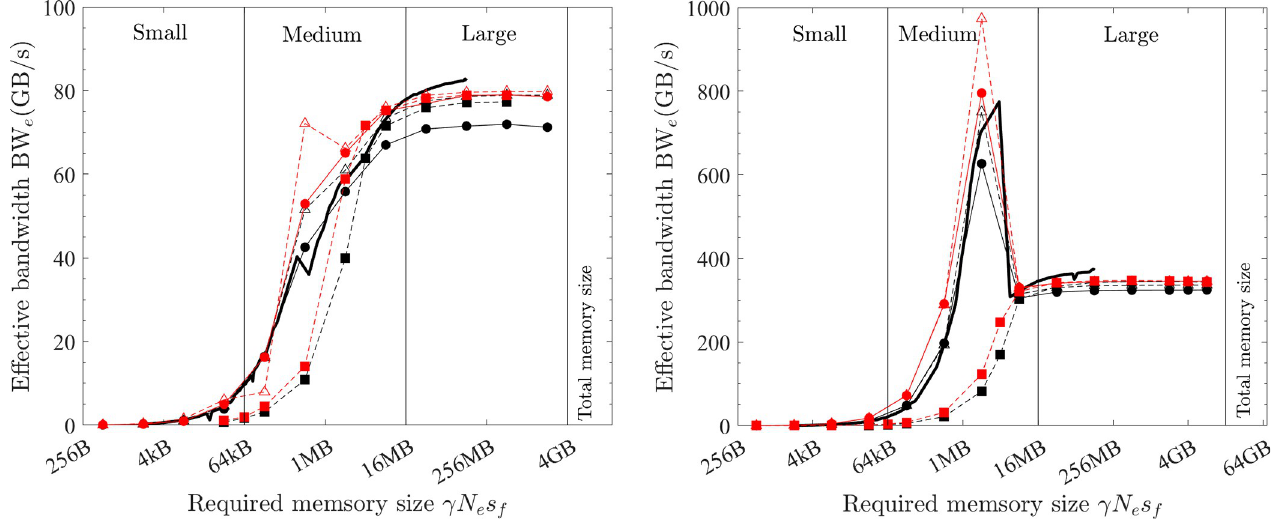
Fig 8. Optimal implementation of vector operations on the GPU platform (single precision; solid black line = benchmarked bandwidth; lines + symbols = effective bandwidth; black = COPY1D; red = XPXPY20_1D; filled circles = CUDA f32, hollow triangles = CUDA float4; filled squares = XLA). (a) PC. (b)